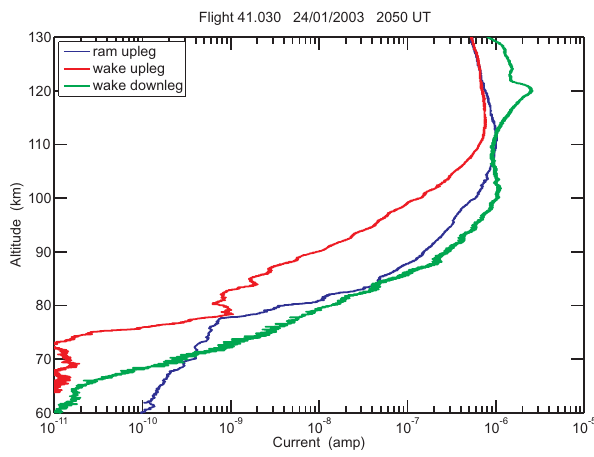
Fig. 17. Comparison of electron current measurements for Flight 41.030 (24 January 2003, 20:50